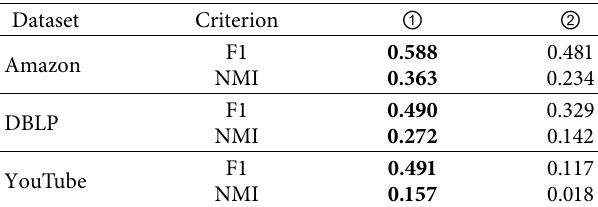
Table 4: Experimental results demonstrating the effectiveness of eliminating overlaps (F1 and